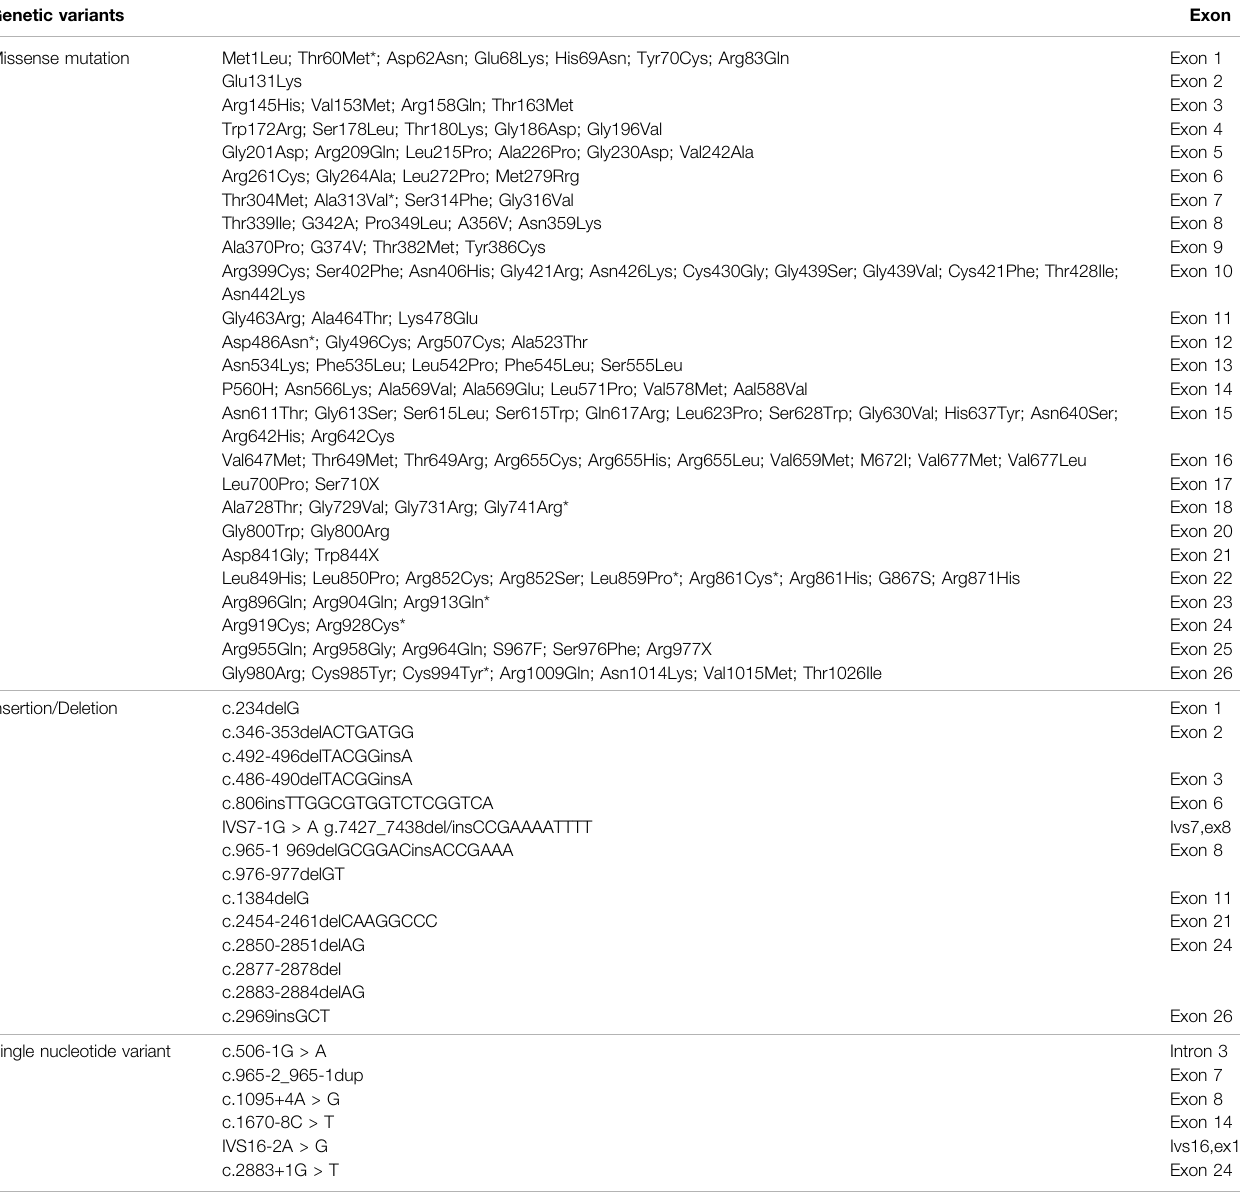
TABLE 3 | Genetic variation in the SLC12A3 gene in Gitelman syndrome. Genetic variants Missense